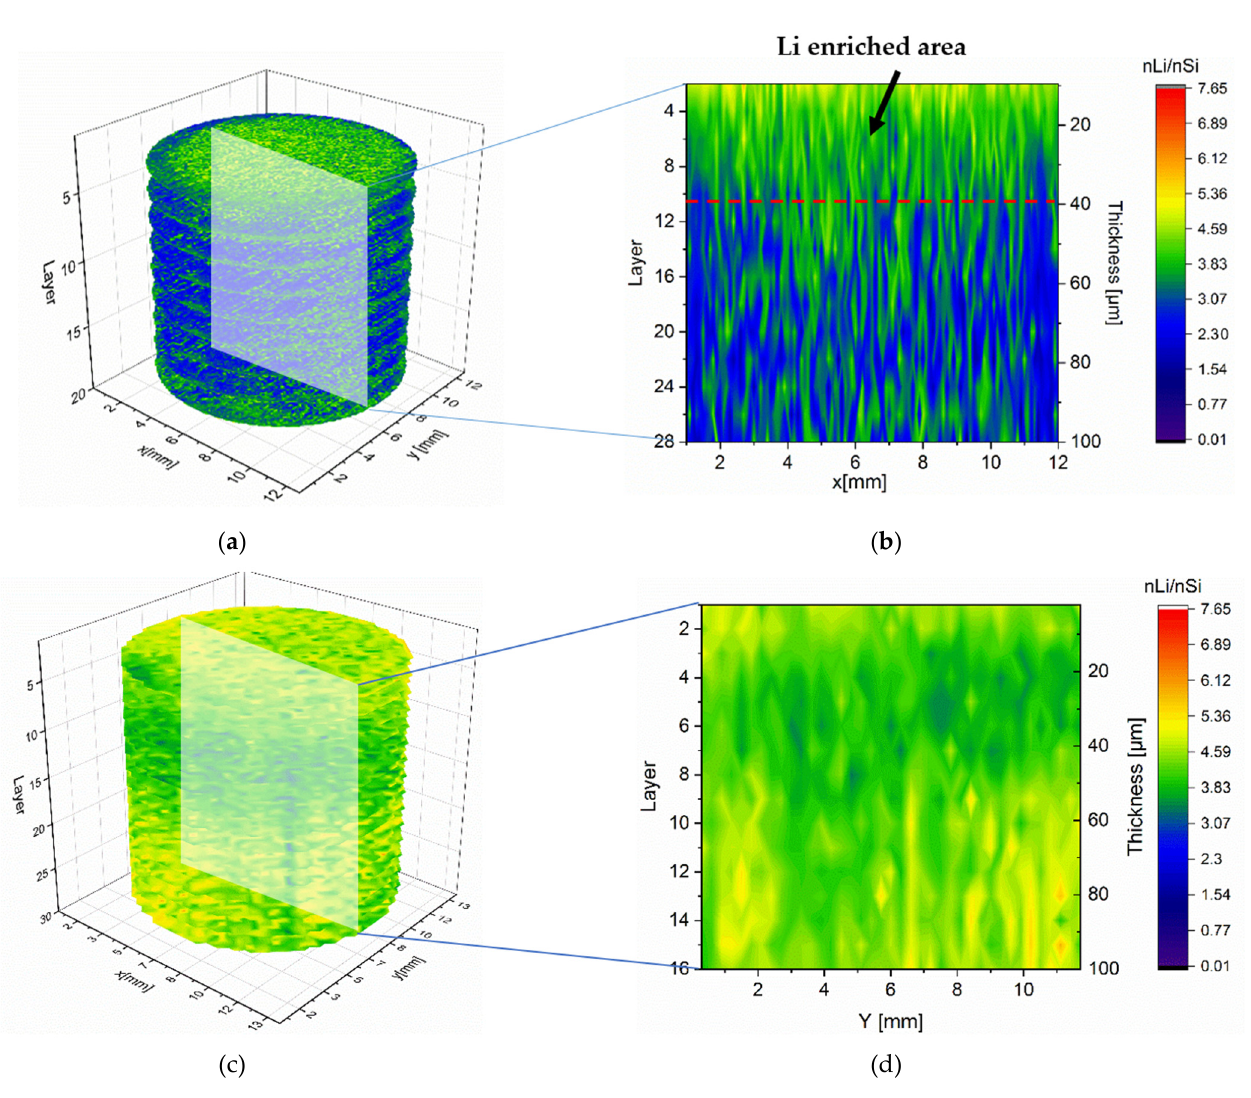
Figure 7. Lithium concentration profile in entire structured and unstructured Si/C electrodes lithiated at 1C: ( a ) 3D illustration of lithium concentration in a reference electrode, ( b ) its lithium distribution in the cross-sectional view, ( c ) 3D illustration of lithium concentration in a structured electrode (pitch distance: 300 µm), and ( d ) its lithium distribution in the cross-sectional view. A dramatic increased coulombic efficiency was obtained in the first cycle when the operation current was changed from high C-rate (2C) to low C-rate (0.1C). The reason could be experimentally explained by means of LIBS measurements on the delithiated electrodes. The lithium concentration of the structured and unstructured electrodes after delithiation at 1C is shown in Figure 8. The studying electrodes were lithiated with a low C-rate of 0.2C to ensure a complete lithiation and subsequently were delithiated at 1C to 1.5 V, keeping for 10 min. In the unstructured electrode, an average lithium concentration of 3.27 ± 0.75 was detected. Due to the laser-generated new diffusion pathways along the channel sidewalls, the lithium-ions could efficiently be extracted from the electrode mate- rial and revealed a lower average concentration of 2.70 ± 0.45. The residual lithium in the electrode, which could not be completely extracted from the host material, led to the ca- pacity fading at high C-rates. The process is particularly reversible, and the residual lith- ium in the electrode can be extracted by applying low C-rates, which can explain the ex- tremely high coulombic efficiency in Figure 4b after switching to a low C-rate.